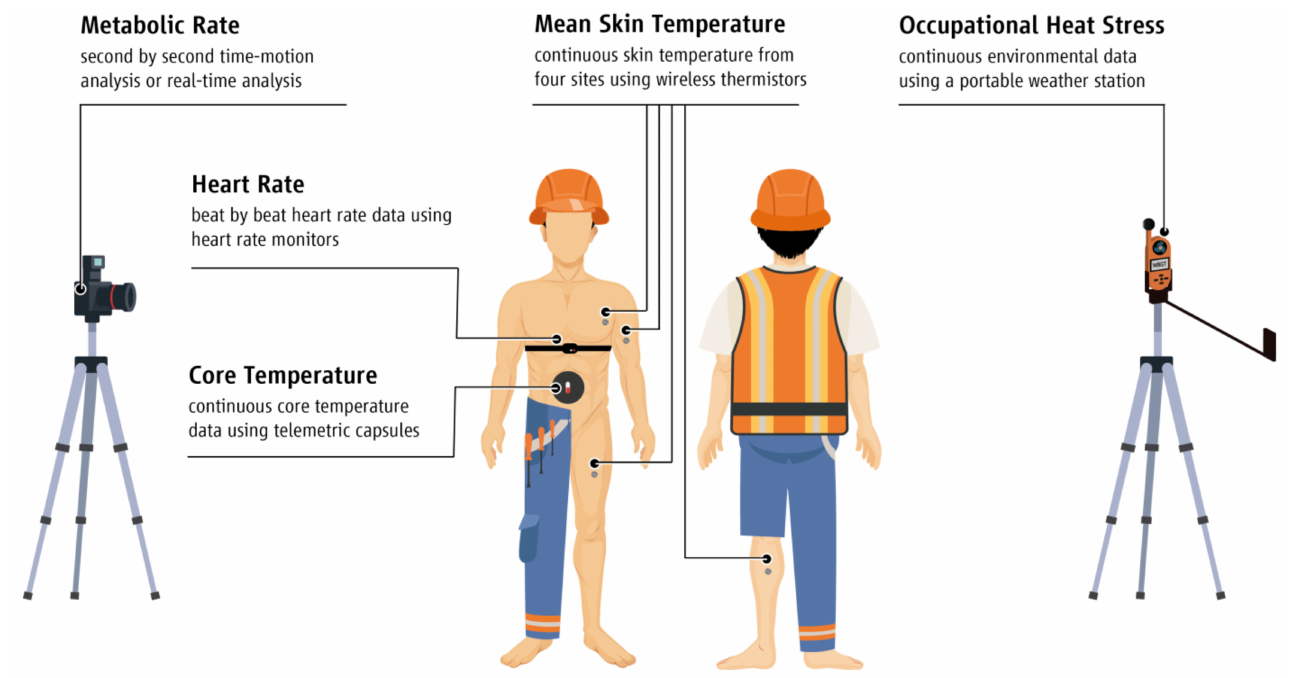
Figure 1. Data collection throughout the